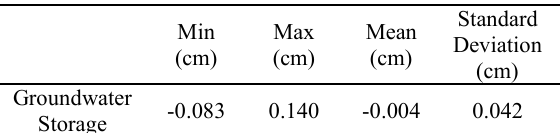
Table 1. Statistical analysis of the average GWS in Peninsular Malaysia from 2002 until 2017 3.2 Variation of GWS from 2002 to 2017 in Peninsular